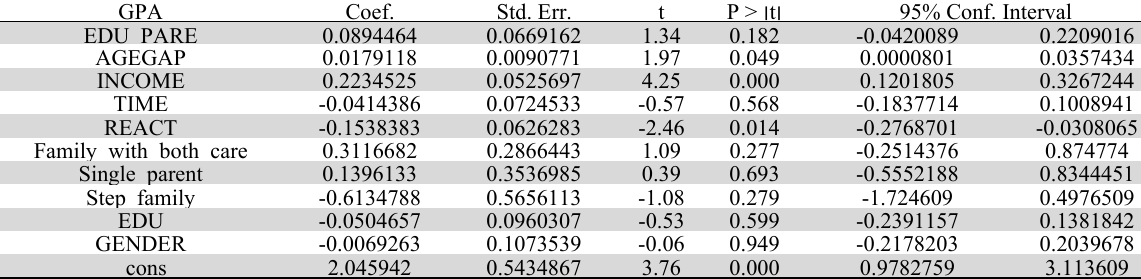
The results of regression